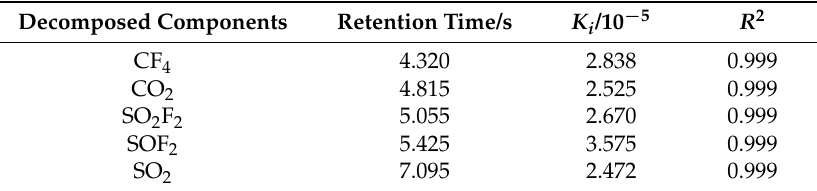
Figure 2. Structure of PD gas chamber: 1: gas chamber; 2: High-voltage (HV) bushing; 3: HV conductor; 4: ball valve; 5: vacuum pressure gauge; 6: vacuum pump; 7: injection port; 8: support insulator; 9: ground conductor; 10: insulation defect; and 11: sampling port. Table 1. The retention time and absolute calibration factor K i .